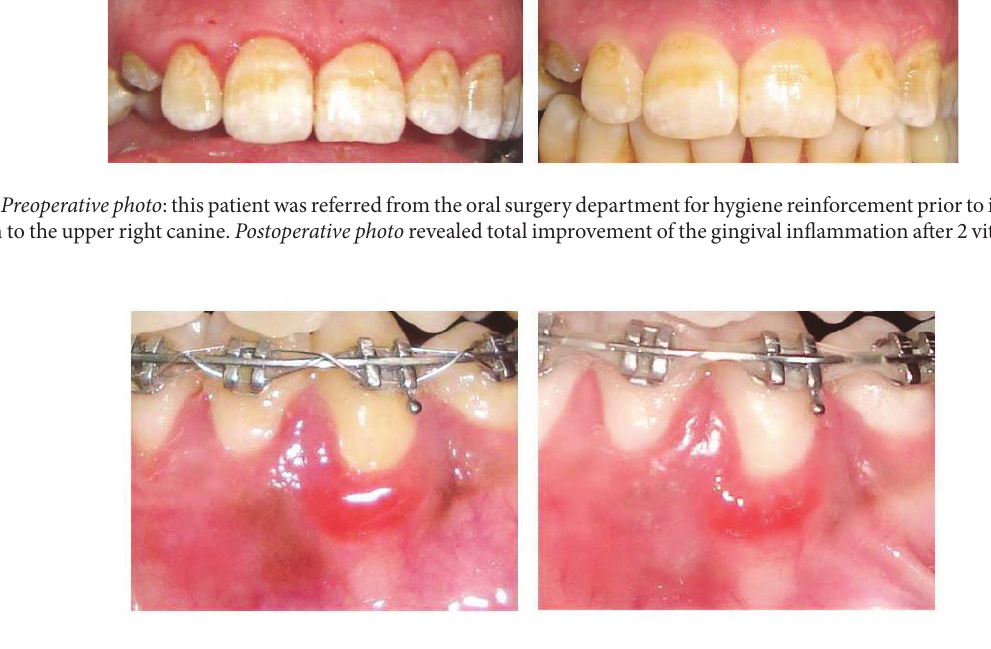
Figure 4: Preoperative photo : this patient was referred from the orthodontic department suffering from severe bleeding gums. Postoperative photo revealed partial improvement of the gingival inflammation after 2 vitamin C injections. The patient needed further injection for total